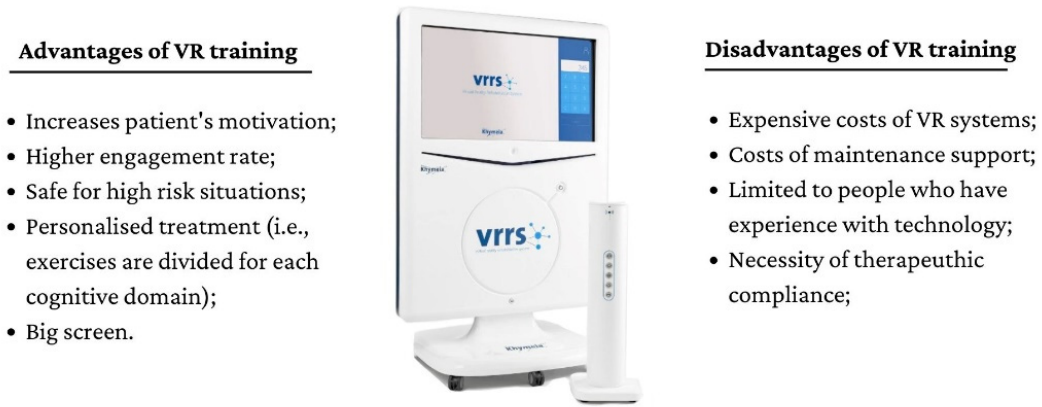
Figure 1. The virtual reality system used to train traumatic brain injury patients showing both advantages and disadvantages about its use in cognitive rehabilitation.